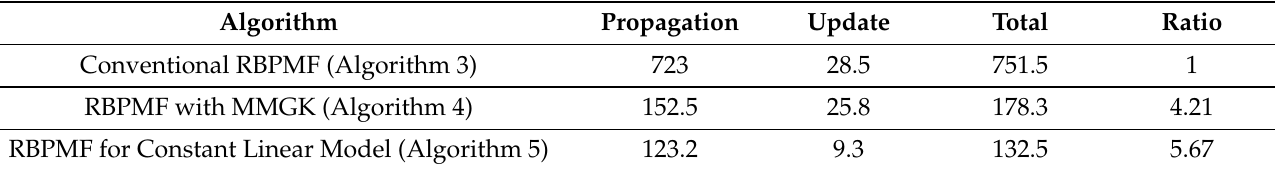
Table 3. Comparison of the average computation time per epoch of the RBPMF algorithms (unit: ms).